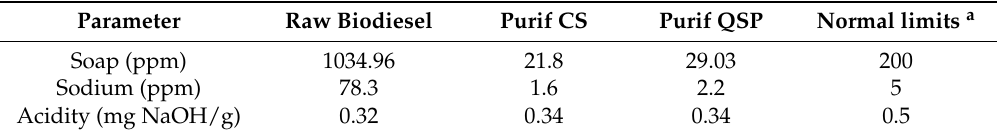
Table 3. Properties of Biodiesel after adsorption process.